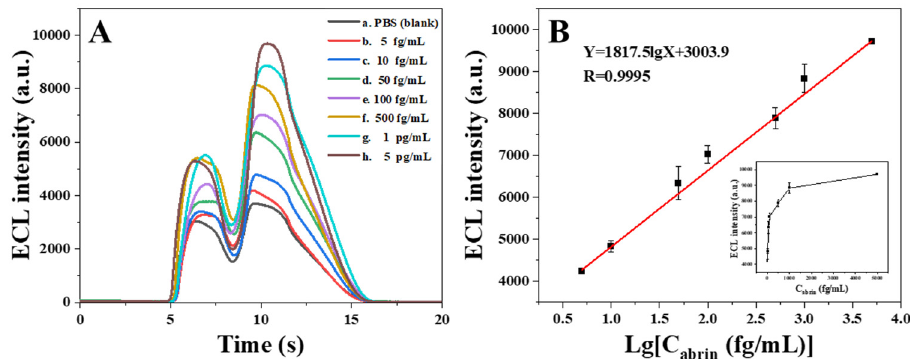
Figure 8. ( A ) ECL real-time curves for samples with different abrin concentrations (a. PBS; b. 5 fg/mL; c. 10 fg/mL; d. 50 fg/mL; e. 100 fg/mL; f. 500 fg/mL; g. 1 pg/mL; h. 5 pg/mL). ( B ) Fitted curve and regression equation for ECL values versus abrin concentration.